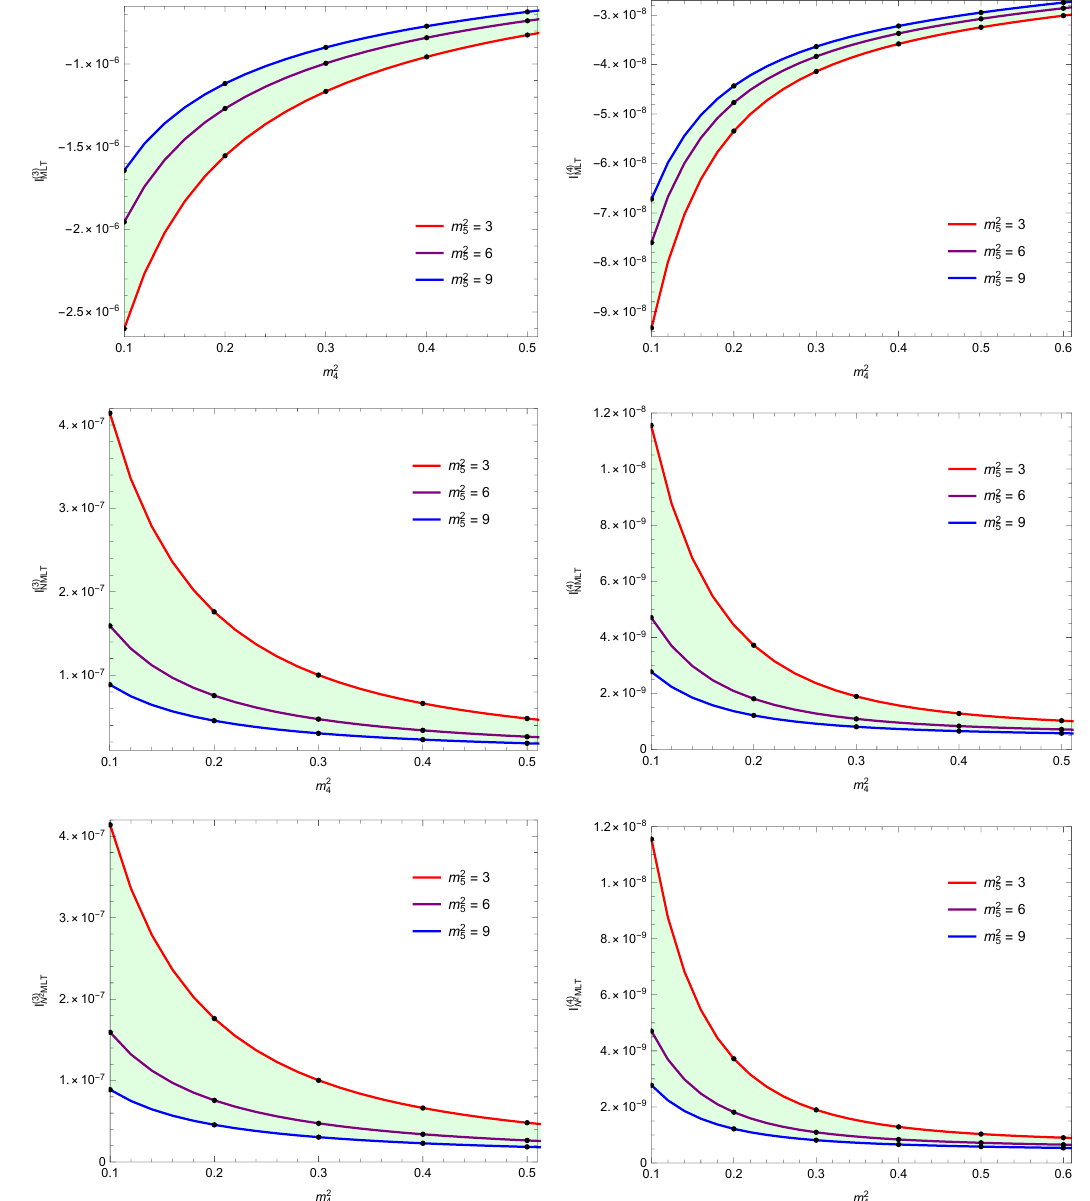
Figure 9 . Four-dimensional MLT, NMLT and N 2 MLT at three and four loops, as a function of the internal masses m 2 and m 2 . Solid lines correspond to the analytic results of LTD and dots to 4 5 the numerical results of Fiesta 4.2